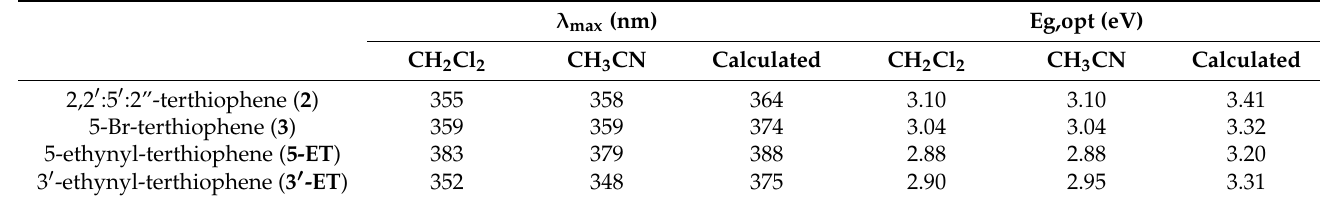
Table 2. Experimental λ max and Eg values compared to calculated values.